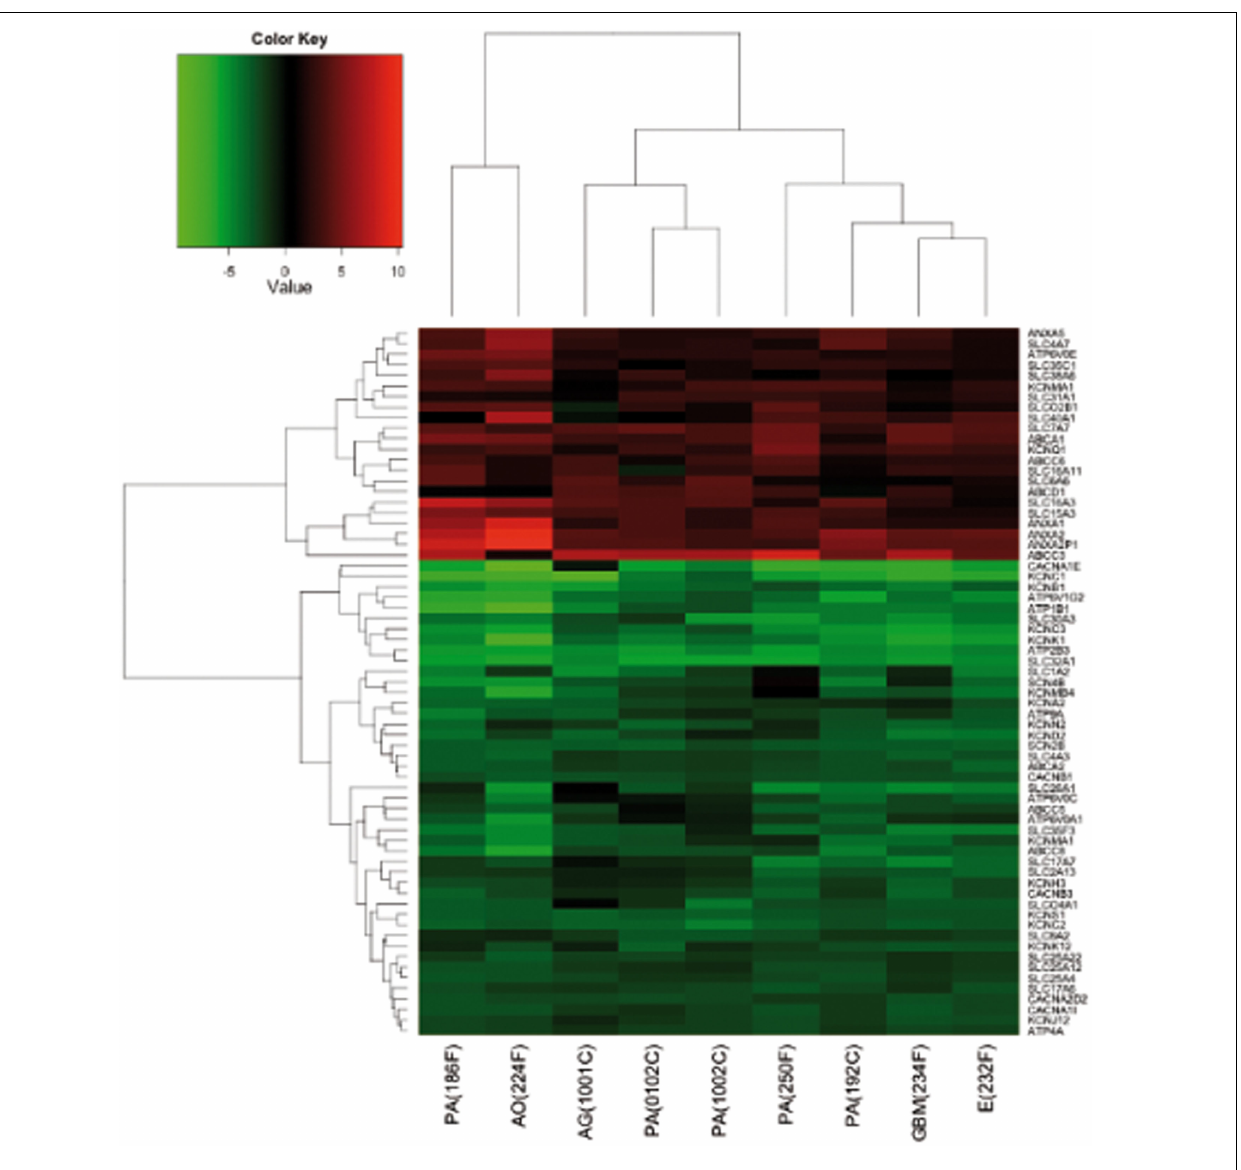
basis of the average value of gene expression (log2 ratio), and give rise to groups of genes and samples with similar average expression levels, according to the color key on the